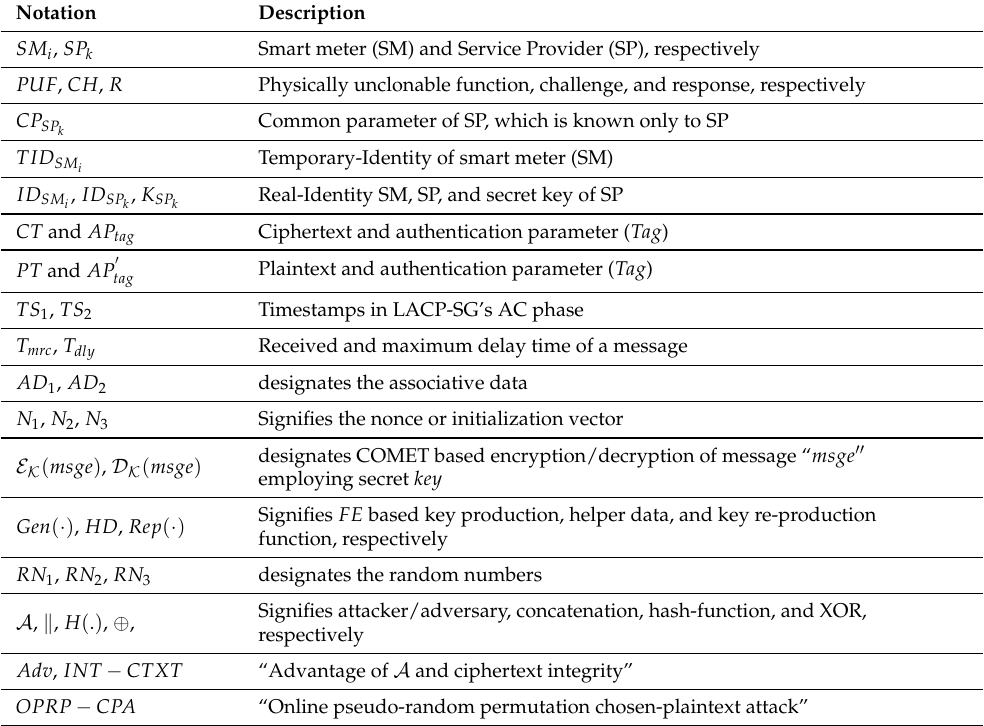
Table 2. Notations used in